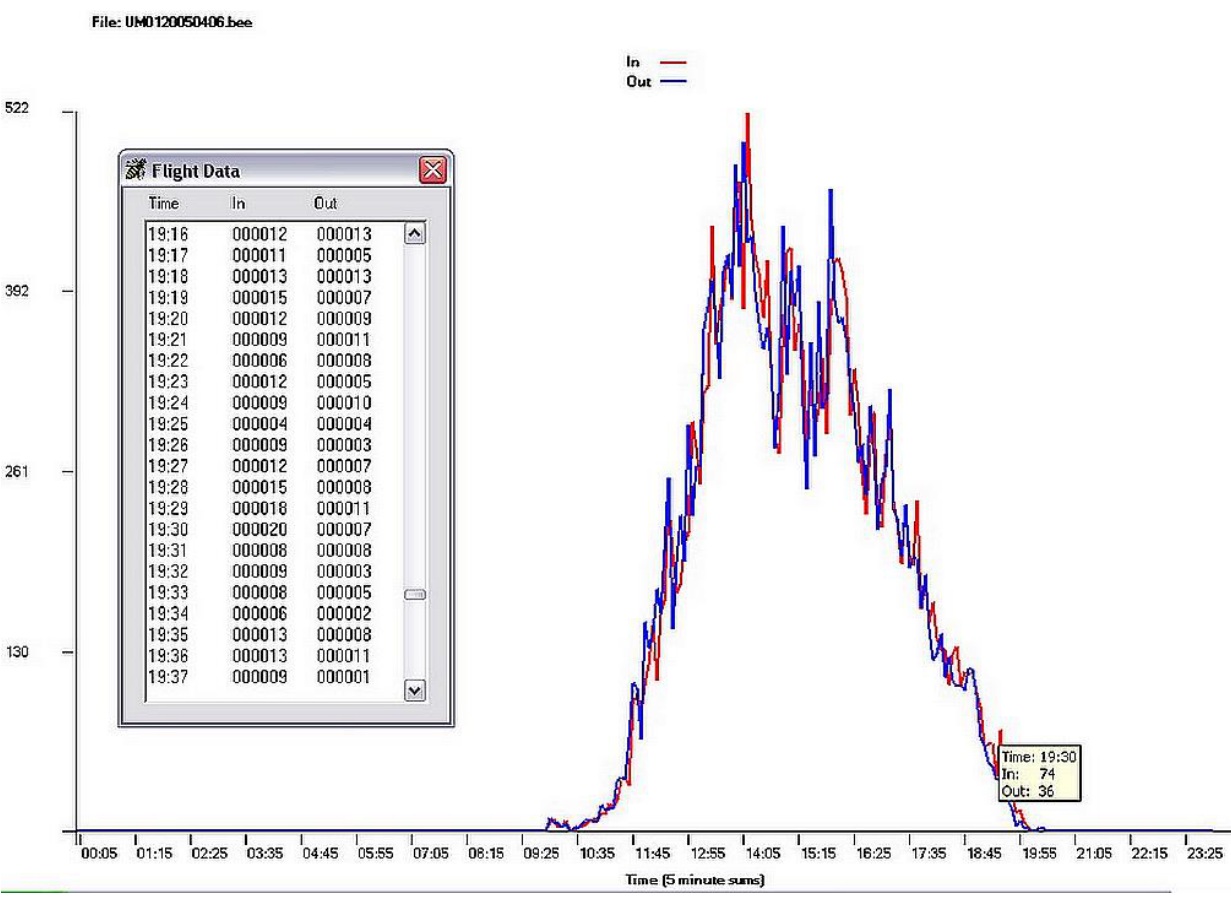
Figure 7. Screen captures of bee foraging data from bi-directional bee counters, 1995. The scrollable table and chart show a single colony’s daily forager activity (bee egress in red, bee ingress out blue) over 24 h. The data table can be accessed by tapping the activity plot at any point. A toggle brings up daily summaries for each colony by